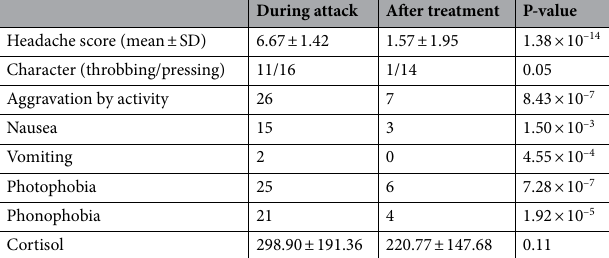
Table 1. Characteristics during attack and two hours after